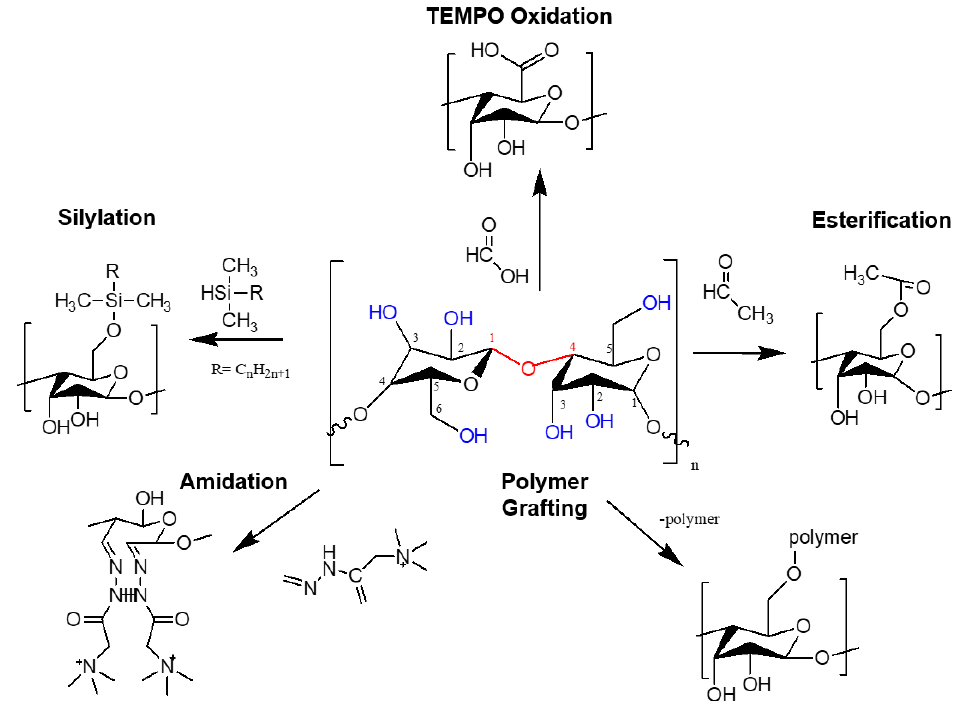
Figure 6. Chemical modification of nanocellulose.